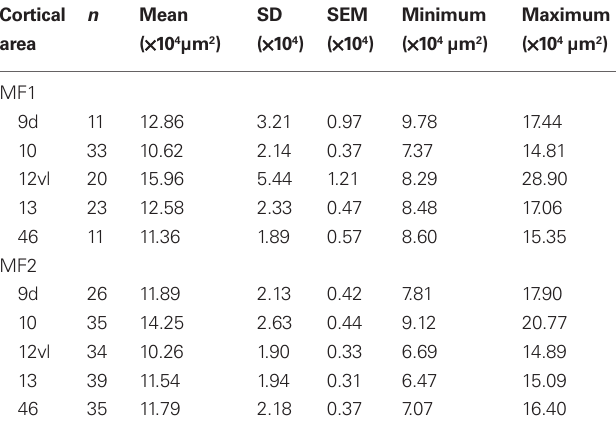
Table 1 | Number, size [mean, standard deviation (SD), standard error of the mean (SeM), minimum, and maximum] of the basal dendritic trees of layer iii pyramidal cells in cortical areas 9, 10, 12vl, 13, and 46 in the prefrontal cortex of the macaque monkey.